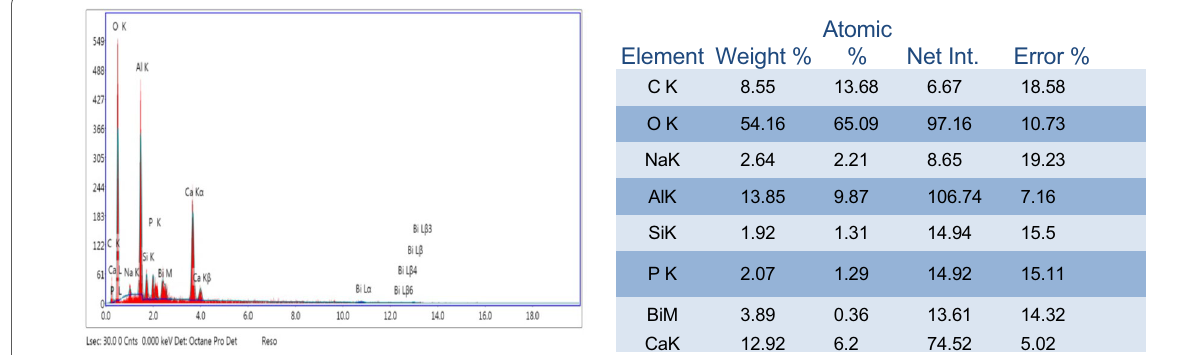
Fig. 13 EDAX analysis of 14-day sample cured in simulated body fluid (SBF)